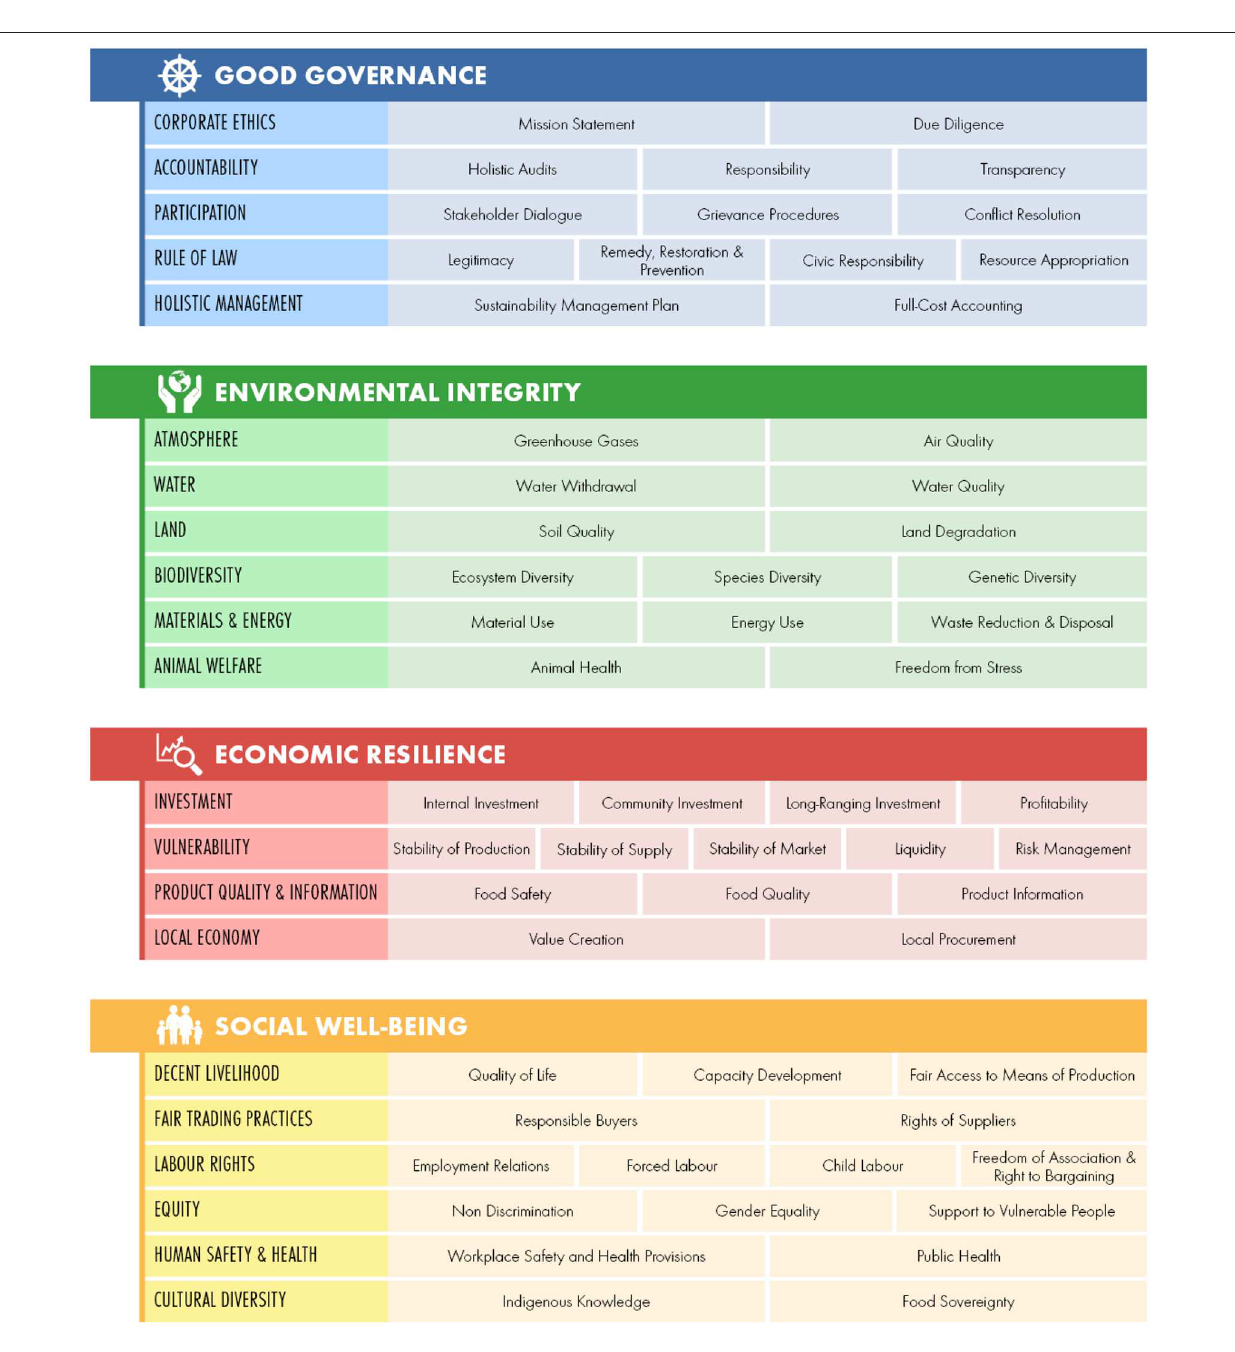
FIGURE 1 | Dimensions, themes, and subthemes of the SAFA Guidelines (FAO,